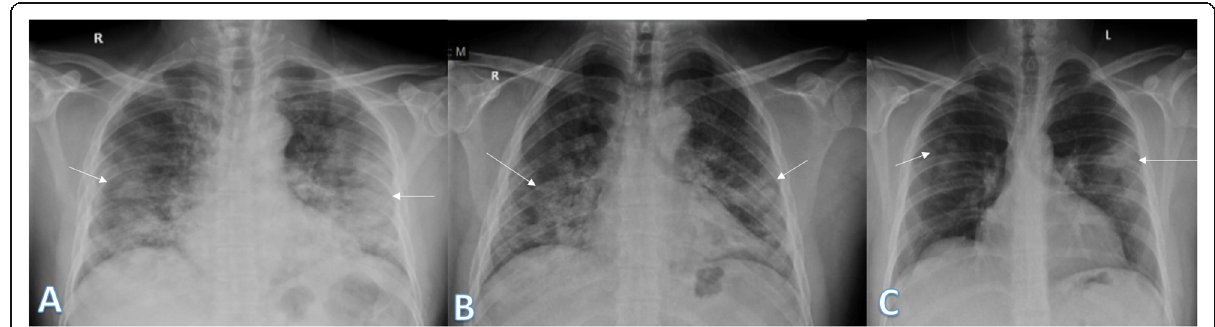
Fig. 3 Three different patients with positive COVID-19. a 54-year male was complaining of SOB, fever, and cough. Initial chest X-ray showed bilateral mid and lower zonal air space consolidation opacities more on the left side with neither perihilar nor peripheral distribution (arrows). The severity score was 2 for the right lung and 3 for the left lung, so TSS was 5. b 36-year male was complaining of fever. Initial chest X-ray showed right perihilar (long arrow) and left neither peripheral nor perihilar air space consolidation opacity (short arrow) of the mid and lower lung zone. The severity score was 2 for each lung, so the total severity score was 4. c 27-year male was complaining of cough and fever. Initial chest X-ray showed right small midzonal pulmonary nodules (short arrow), left midzonal neither peripheral nor perihilar air space consolidation opacities are seen (long arrows), and the severity score was 1 for each lung, so TSS was 2